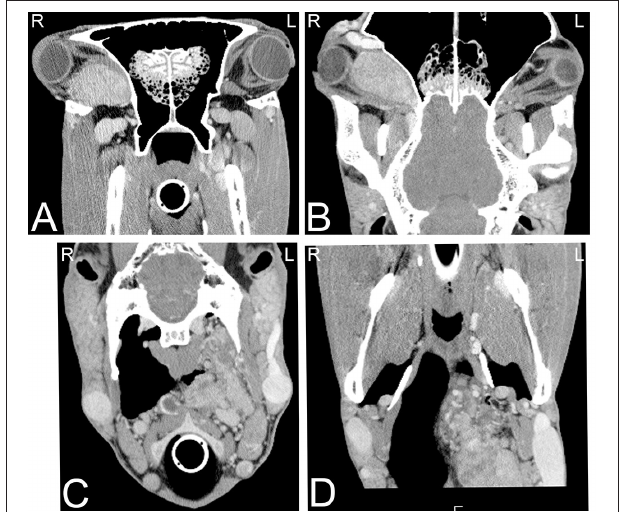
FIGURE 19 | Neuroendocrine tumor. Transverse (A,C) and dorsal (B,D) computed tomography images post intravenous iodinated contrast medium injection displayed in soft tissue window demonstrating large retrobulbar (A,B) and retropharyngeal (C,D) masses, which were confirmed as a multicentric neuroendocrine tumors. CT images at the level of retrobulbar space (A,B) illustrate a large, well defined, mildly heterogeneously contrast enhancing mass, which displaces the eye laterally and caudally and the optical nerve caudally and does not involve the optical nerve. Additionally, a large lobulated, highly vascularized, moderately heterogeneously contrast enhancing mass is noted in the left retropharyngeal area (C,D) , resulting a reduced size of the left guttural pouch. L, left; R,